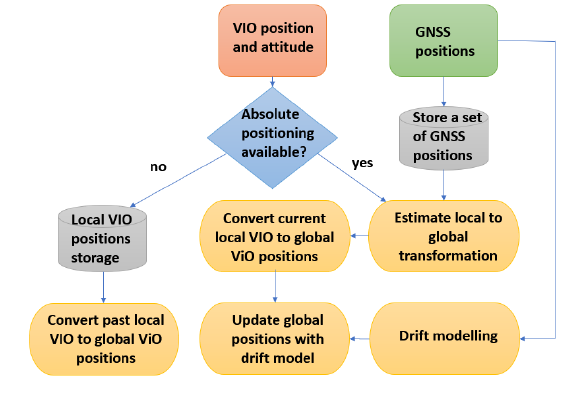
Figure 3. Flowchart for the sensor fusion